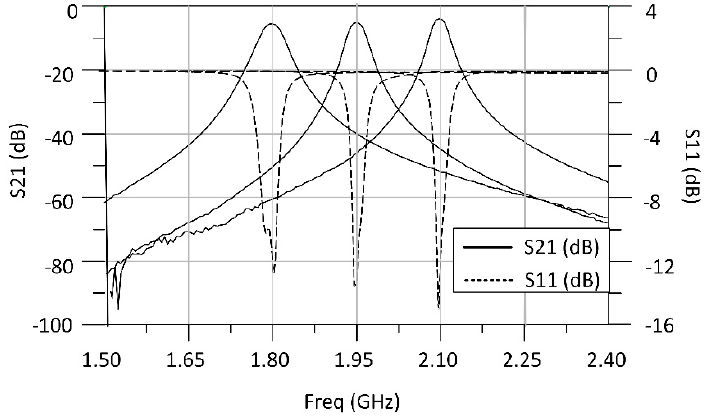
Figure 12. Measured S-parameters of the two-cell filter at three frequencies in the tuning range.